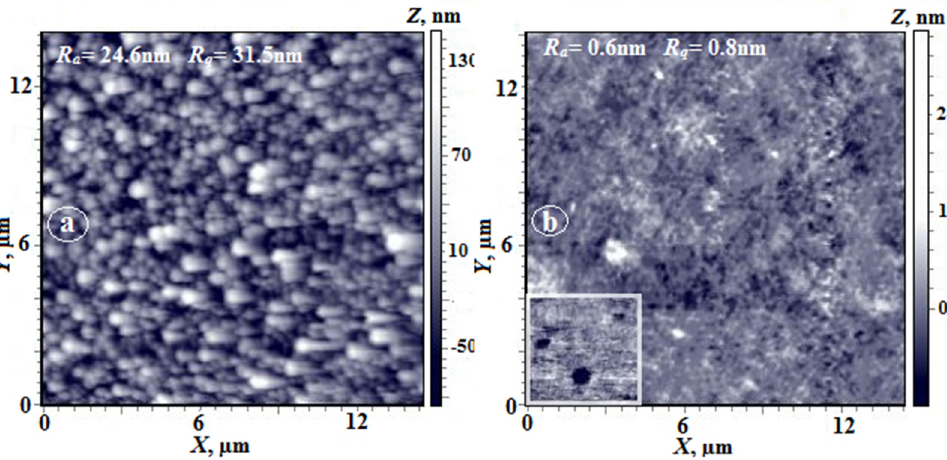
Figure 6. AFM height image of surface of film coPAI-3; ( a , b ). a—the upper surface, b—the substrate-side surface. The inset in Figure 6b presents a contrast of lateral forces.